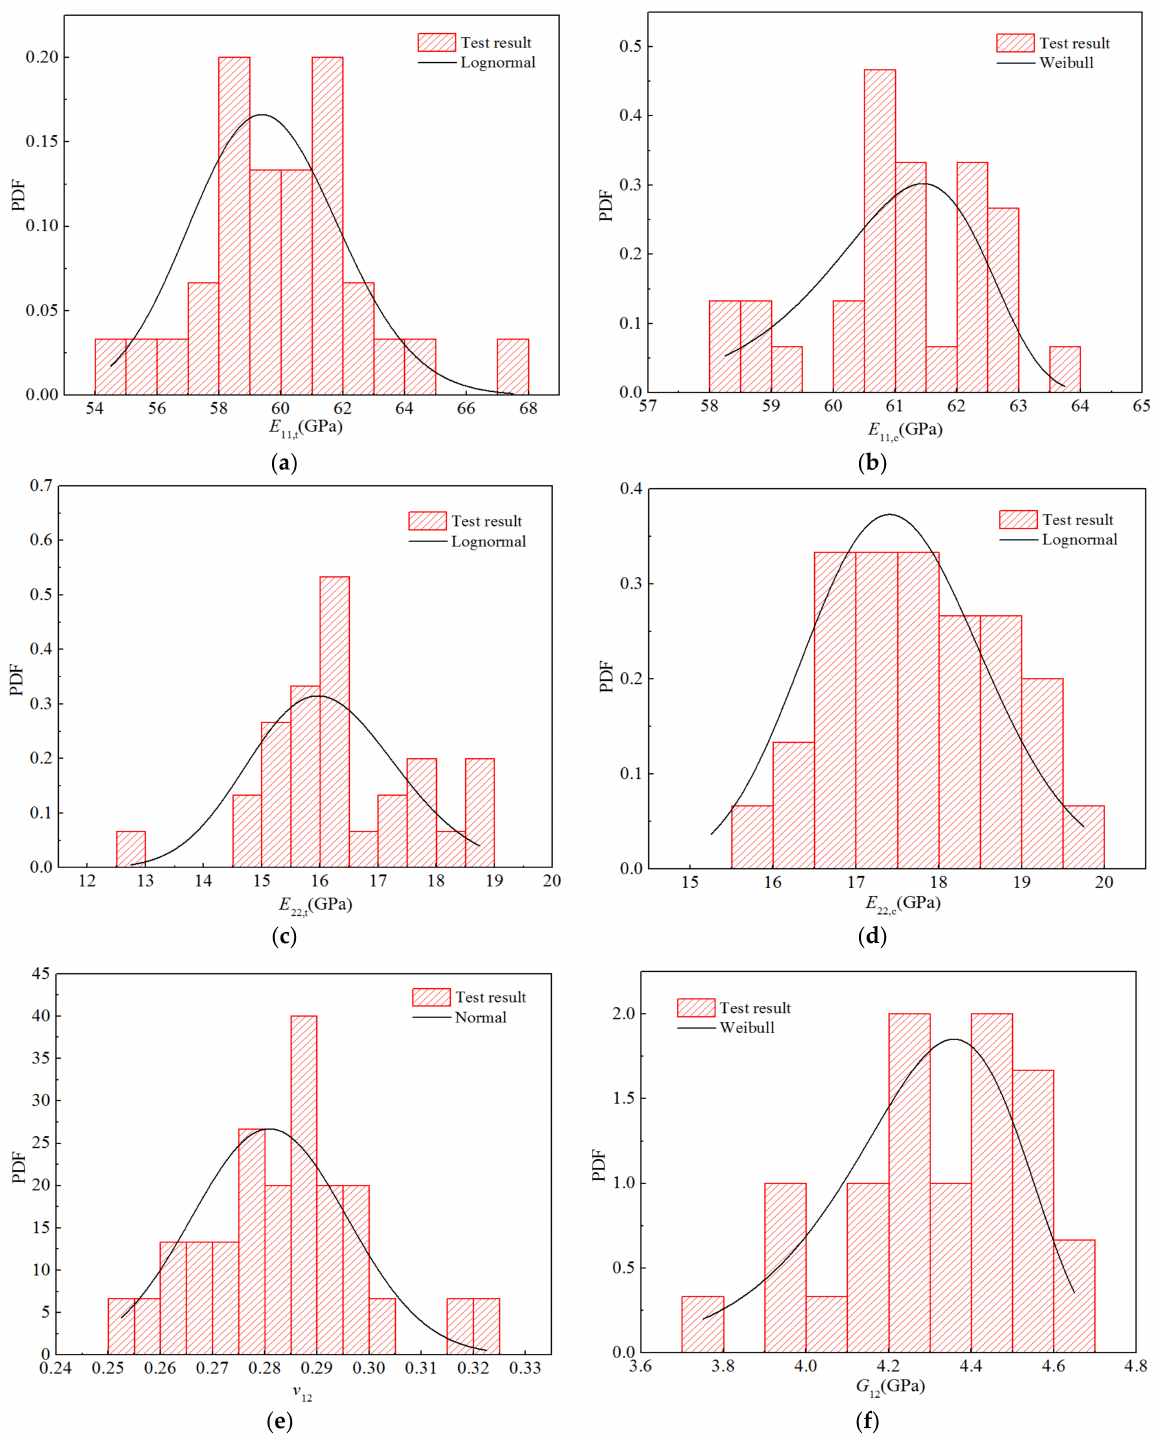
Figure 7. Probability function diagrams for the stiffness properties of H-GFRPs at RT. ( a ) E 11,t ,